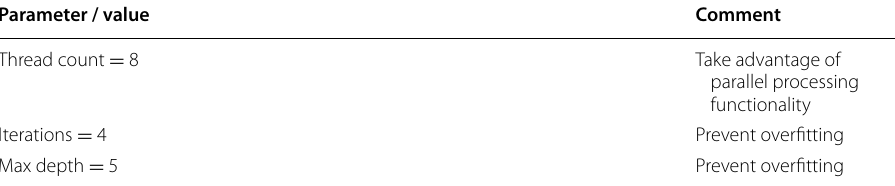
Table 4 CatBoost classifier hyper-parameters